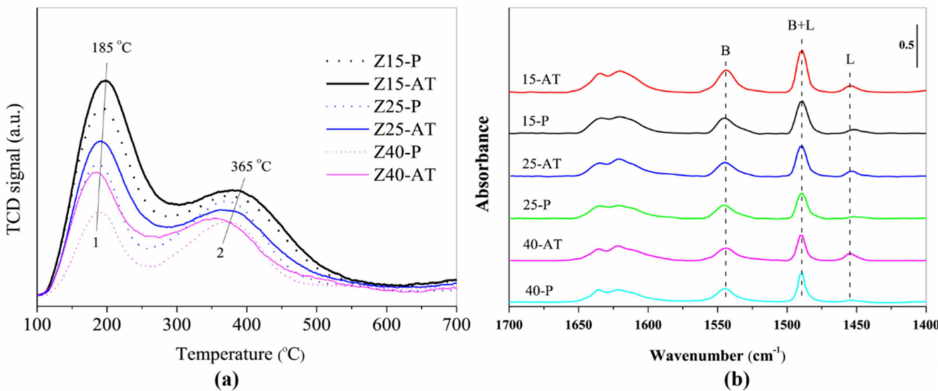
Figure 14. ( a ) NH 3 -TPD profiles of the parent and alkali-treated HZSM-5. ( b ) Pyridine FTIR spectra of the parent and alkali-treated HZSM-5. Z15, 25, and 40 denote HZSM-5 with SiO 2 /Al 2 O 3 ratios of 15, 25, and 40. P denotes parent. AT denotes alkali treatments. Reprinted with permission from Zhang et al. [135]. Copyright (2019)